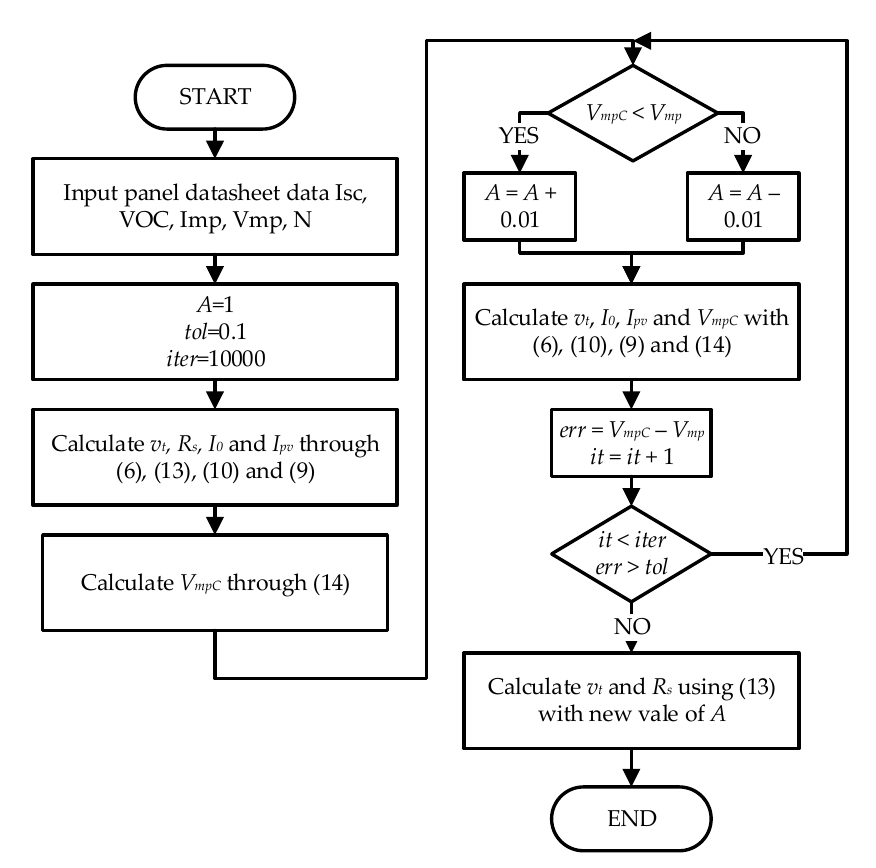
Figure 2. Step 1 of the proposed method.